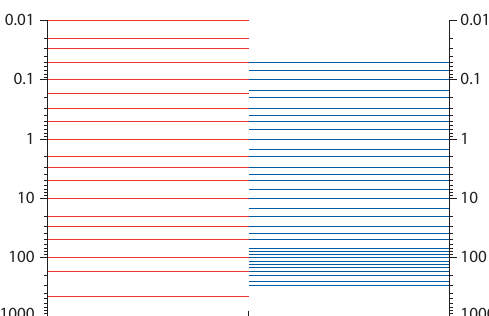
Figure 2. Schematic of the two ozone products’ vertical coverage and vertical resolution as provided by the CCI GOME-2 (red lines) and the CCI MIPAS (blue lines) retrieval algorithms. The verti- cal axis represents pressure in hPa. The surface pressure level for GOME-2 is for illustration purposes drawn at